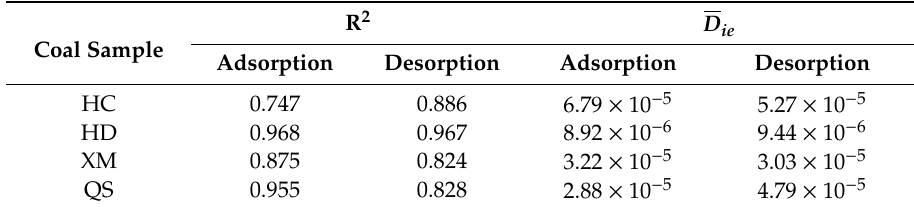
Figure 7. The diagram of variation of micro-diffusion coefficient with pressure. Table 5. Goodness of fit and diffusion coefficient.